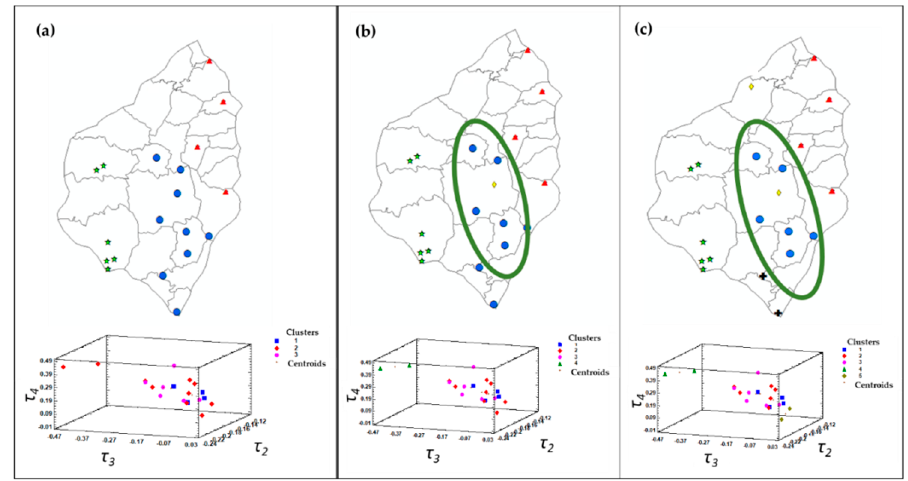
Figure 3. Geographical distribution of clusters and scatter plots of τ 2 vs. τ 3 vs. τ 4. Distributions with: ( a ) tree clusters, ( b ) four clusters, ( c ) five clusters.